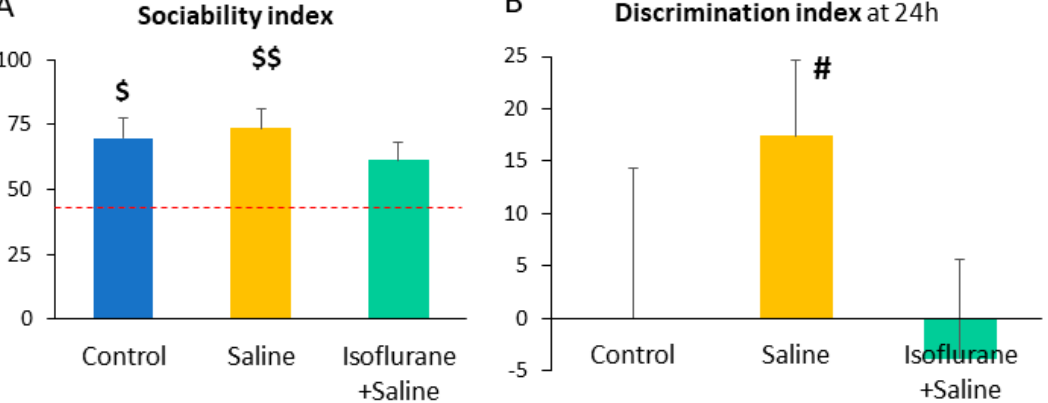
Figure 3. Sociability ( A ) and discrimination ( B ) indices. The comparison of the three groups of C57Bl/6 male mice did not reveal any differences (n = 8–10/group). However, only control and saline, but not the isoflurane+saline-treated group had intact social preference ( A ). At 24 h, social discrimination abilities were preserved only in the saline-treated group ( B ). $ p < 0.05; $$ p = 0.01 vs. 50% chance level by single-sample t -test; # p < 0.05 vs. 0% chance level by single sample t -test.